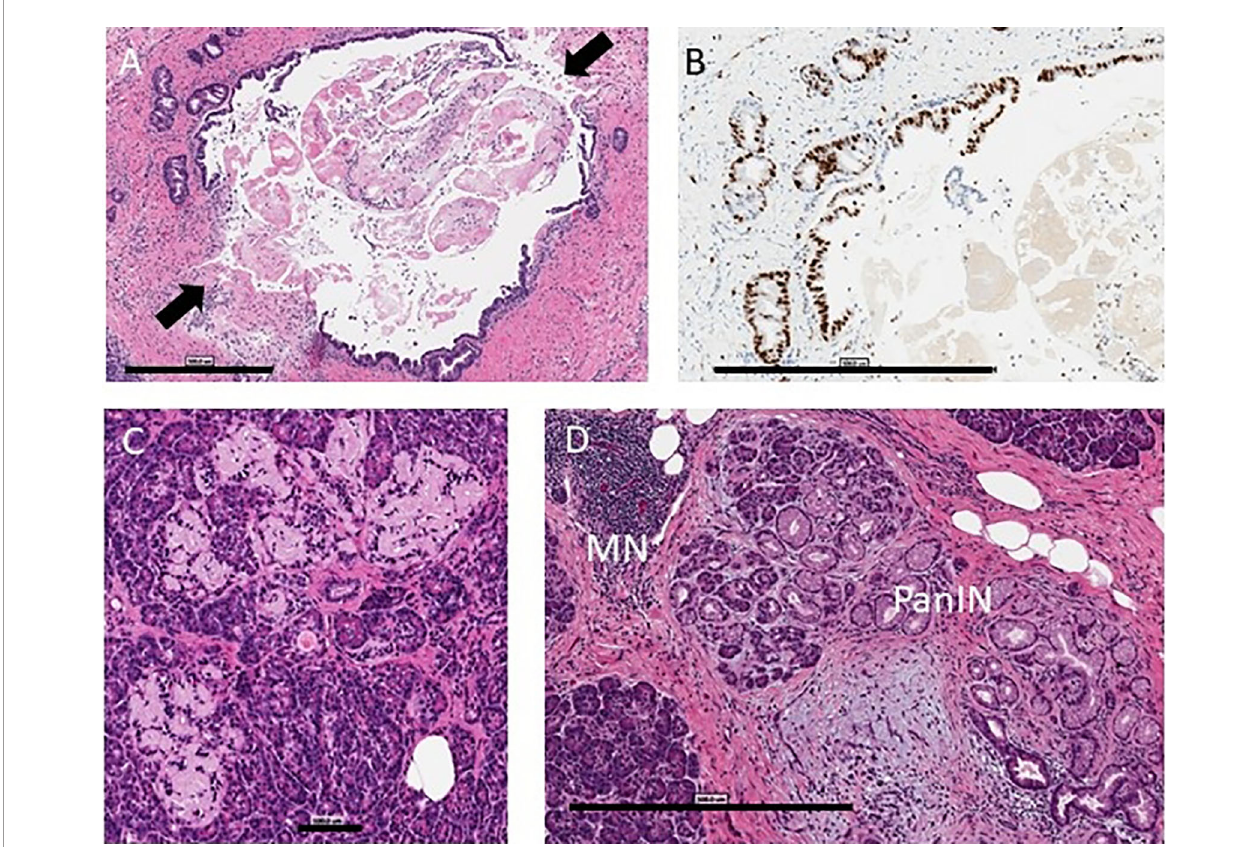
FIGURE 1 | Pancreas histopathology. Representative images are shown from the nPOD Online Pathology database. The whole slide scans can be viewed with account request (https://www.jdrfnpod.org/for-investigators/password-request-form/). (A) Acute pancreatitis is shown by H&E staining in a 14.3 year old donor with type 1 diabetes for 8 years with no reported history of substance use (6089). The main pancreatic duct epithelium was breached at two points (arrows) on this image with intraluminal sludge observed by H&E staining. Scale bar: 500 µm. (B) The main duct and pancreatic duct glands showed very high epithelial Ki67+ cell numbers by IHC staining. Scale bar: 500 µm. (C) Islet amyloidosis in three islets is shown by H&E staining in a 24 year old donor with type 1 diabetes for 2 years who had a positive history of alcohol use and a positive blood ethanol level at the time of organ procurement (257 mg/dL) (6367). Scale bar: 100 µm. (D) Chronic pancreatitis is shown by H&E staining in a 30 year old donor with type 1 diabetes for 23 years (6266) with a positive history of tobacco use with mononuclear in fi ltration (MN), lobular fi brosis, and ductal dysplasia with pancreatic intraepithelial neoplasia (PanIN). Scale bar: 500